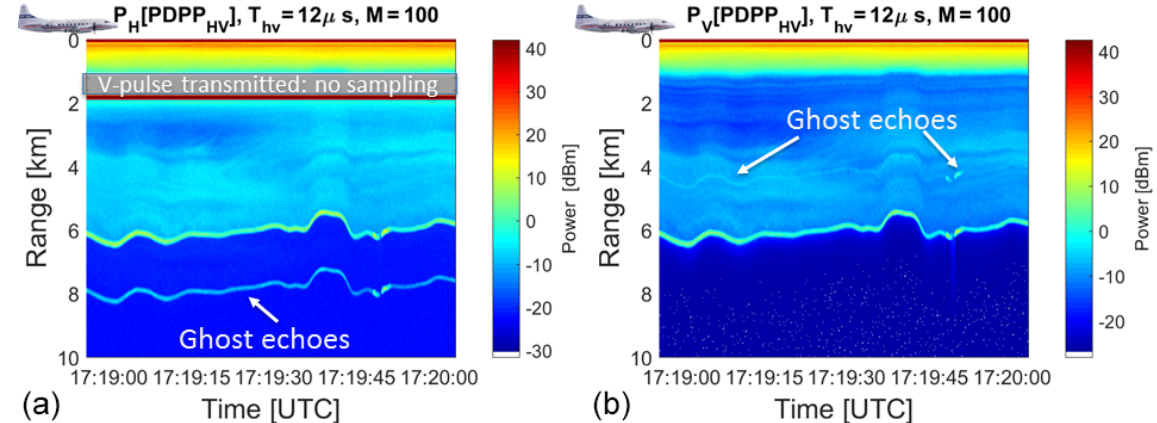
Figure 9. Example of power as recorded when operating in PDPP mode with H -pulse followed by a V -pulse after 12µs. (a) Power received in the H -channel; (b) power received in the V -channel. The mechanism for producing ghost echoes is explained in the upper part of the